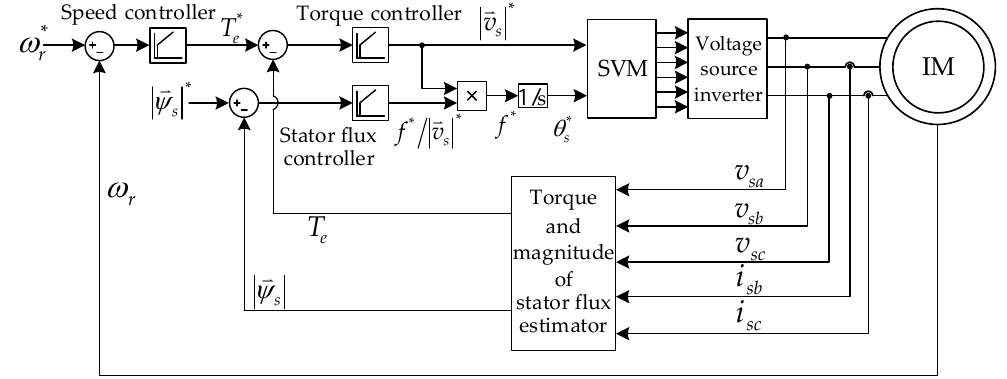
Figure 1. The block diagram of direct torque control based on constant voltage per frequency (V/F) control technique (DTC-CVFC) for three-phase induction motor (IM) drives. SVM: space vector modulation.